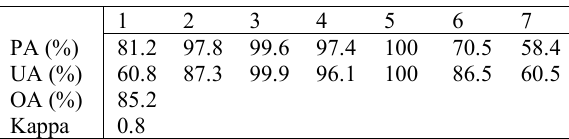
Table 7.2. Results obtained for 2020-year classification. PA: Producers Accuracy; UA: User’s Accuracy; OA: Total precision and Kappa classification.